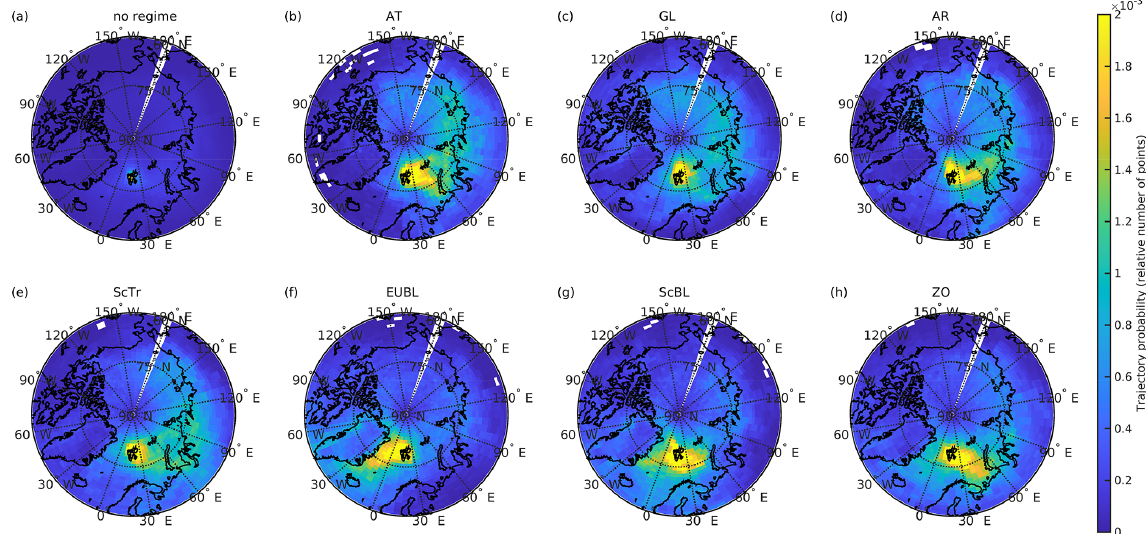
Figure A5. FLEXPART trajectory probability for 10d backward trajectories for the different weather regimes for spring seasons 1990–2018. The percentage of trajectories descending from higher altitudes ( > 2000m) is 18%, 14%, 13%, 15%, 17%, 22%, 21% and 21% for the regimes in plots (a) – (h) ,